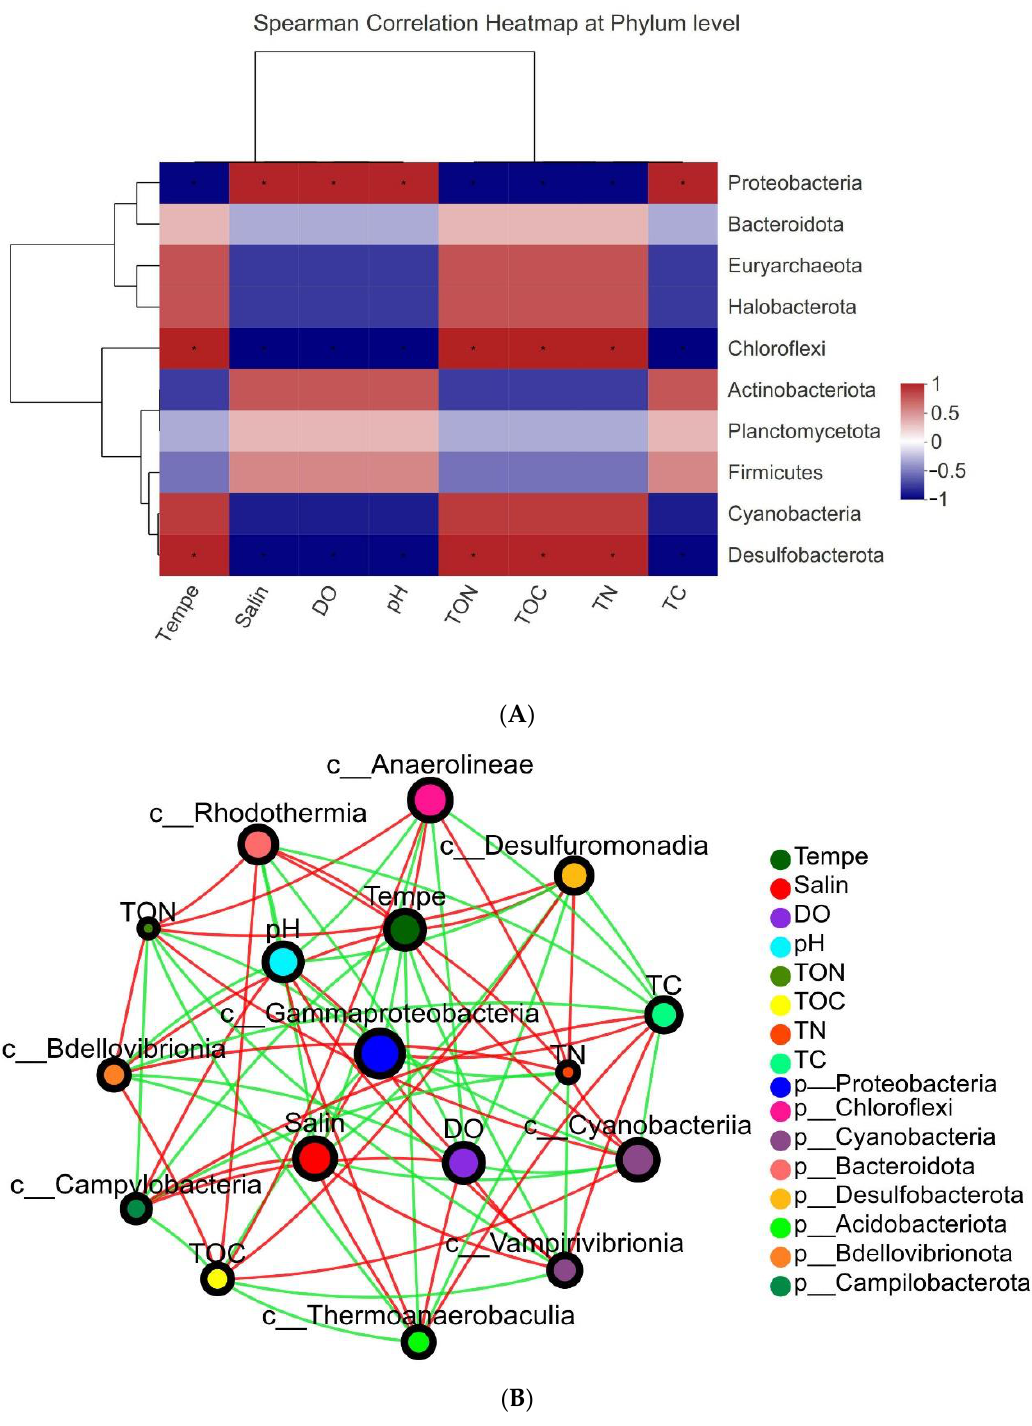
Figure 6. ( A ), Correlation heatmap of the top ten phyla and physicochemical properties. The X and Y axes are physicochemical properties and phyla. The correlation coefficient is shown in different colours, and the right side of the legend is the colour range of varying R values, with p < 0.05 *, respectively. ( B ), Network analysis of the relationships between key species at the class level and environmental factors. Node size represents the relative abundance of different species. The red line represents a positive relationship between species and environmental factors. The green line represents negative relationships between species and environmental factors. Temper: temperature, Salin: salinity, DO: dissolved oxygen, pH, TN, total nitrogen; TOC, total organic carbon; TON, total organic